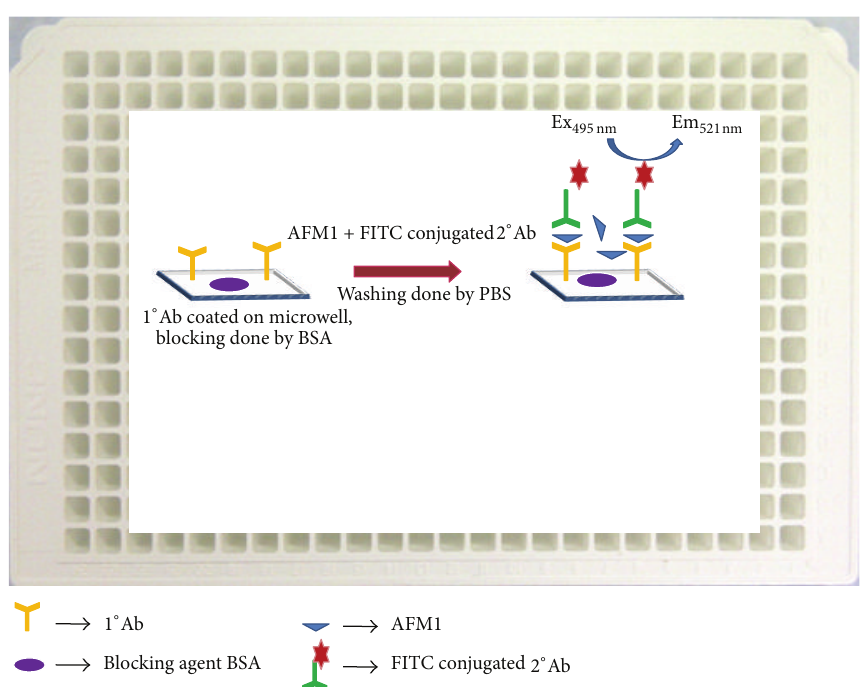
Figure 2: Scheme of fluorimetric ELISA designed for analysis of AFM1.